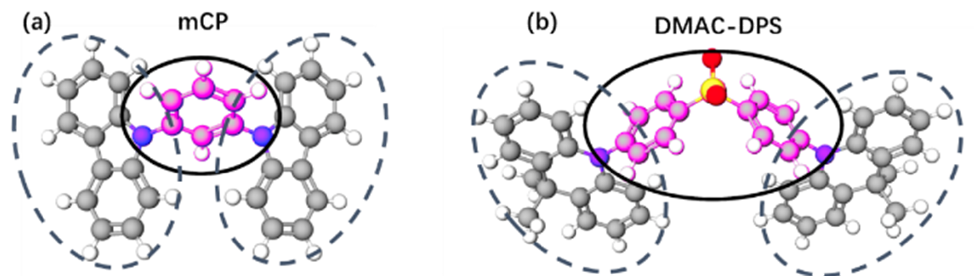
Figure 7. The molecular structures of ( a ) mCP and ( b ) DMAC-DPS. The part marked by the solid line represents the distribution of the molecular LUMO, the dotted line represents the distribution of the molecular HOMO. Table 2. The solubility in polar solvents and lipophilicity of LUMO and HOMO molecular groups. Material